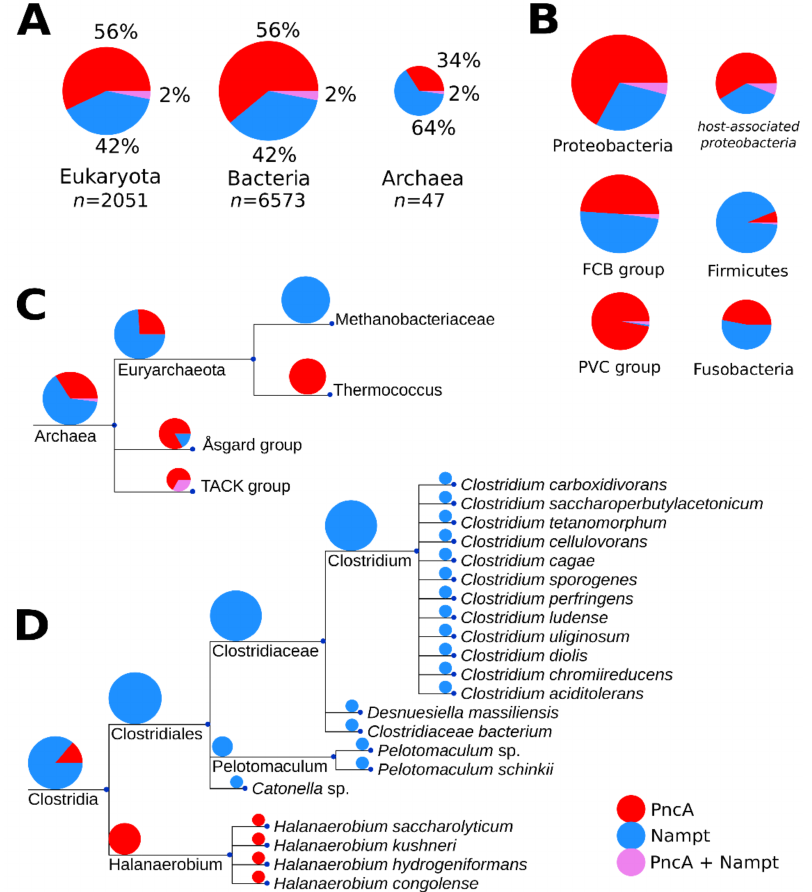
Figure 2. Phylogenetic distribution of PncA and Nampt among the three domains, with expansion into archaea and the bacterial taxa of clostridia. Panel ( A ) shows the total number of organisms ( n ) represented in the phylogenetic analysis, per domain, as well as their proportions as coloured in the following scheme (PncA, red; Nampt, blue; both PncA and Nampt, violet). The numeric proportion is written beside each segment of the pie chart. The pie chart sizes in each panel are scaled proportionally to the logarithm of the number of organisms represented in each group. In panel ( B ), the enzyme distribution in the largest bacterial clades is shown. Host-association patterns in the proteobacterial group are also shown as an additional pie chart to the right of the total proteobacterial pie chart. Panel ( C ) expands on the domain of archea, particularly to two clades within the phylum euryarchaeota that have presence of only PncA (Thermococcus) or Nampt (Methanobacteriaceae). Panel ( D ) expands on the bacterial class of clostridia, which is a member of the phylum firmicutes. Clostridia is one of several bacterial classes that exhibit a clear preference for PncA in extremophiles, based on our phylogenetic analyses. Branch lengths of the trees are